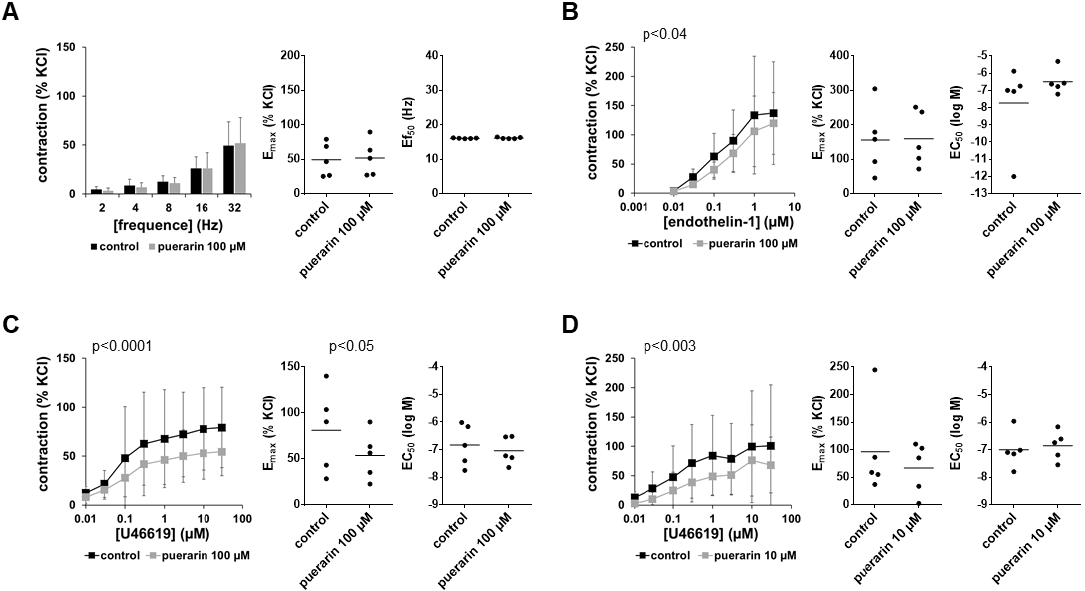
Figure 7. Effects of puerarin on EFS-induced and non-adrenergic contractions of human prostate tissues. Contractions were induced by EFS ( A ), endothelin-1 ( B ) and U46619 ( C,D ), in the presence of 100 µM puerarin ( A , B , C ) 10 µM puerarin ( D ) and corresponding amounts of solvent (methanol) for the controls added 30 min before the construction of frequency and concentration–response curves. Data from experiments with tissues from n = 5 patients are shown in each diagram. In each experiment, tissue from one patient was allocated to the control and puerarin groups. Data are means ± SDs in frequency/concentration–response curves ( p -values for whole groups from two-way ANOVA), and E max , Ef 50 and EC 50 values are from all single experiments (calculated by curve fitting) in scatter plots ( p -values from two-tailed t